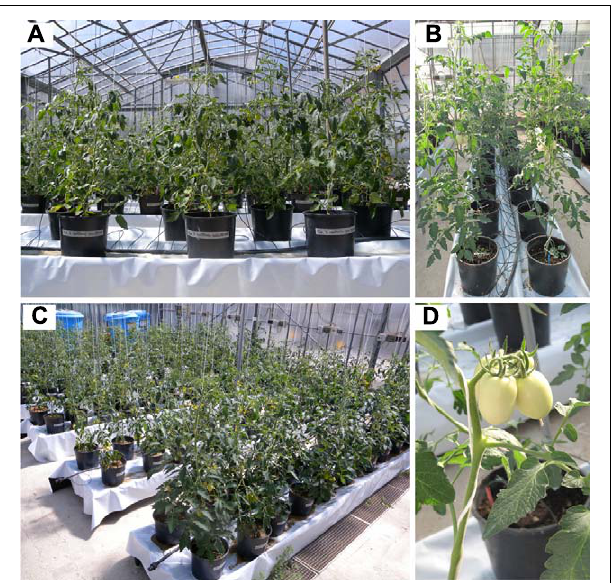
FIGURE 1 | Set-up of tomato plant greenhouse cultivation. Plants were grown in pots (A) and organized in rows (B) , fertilized with a nutritive solution (C) . Iodine treatments started with the set of the first truss of fruits (D)